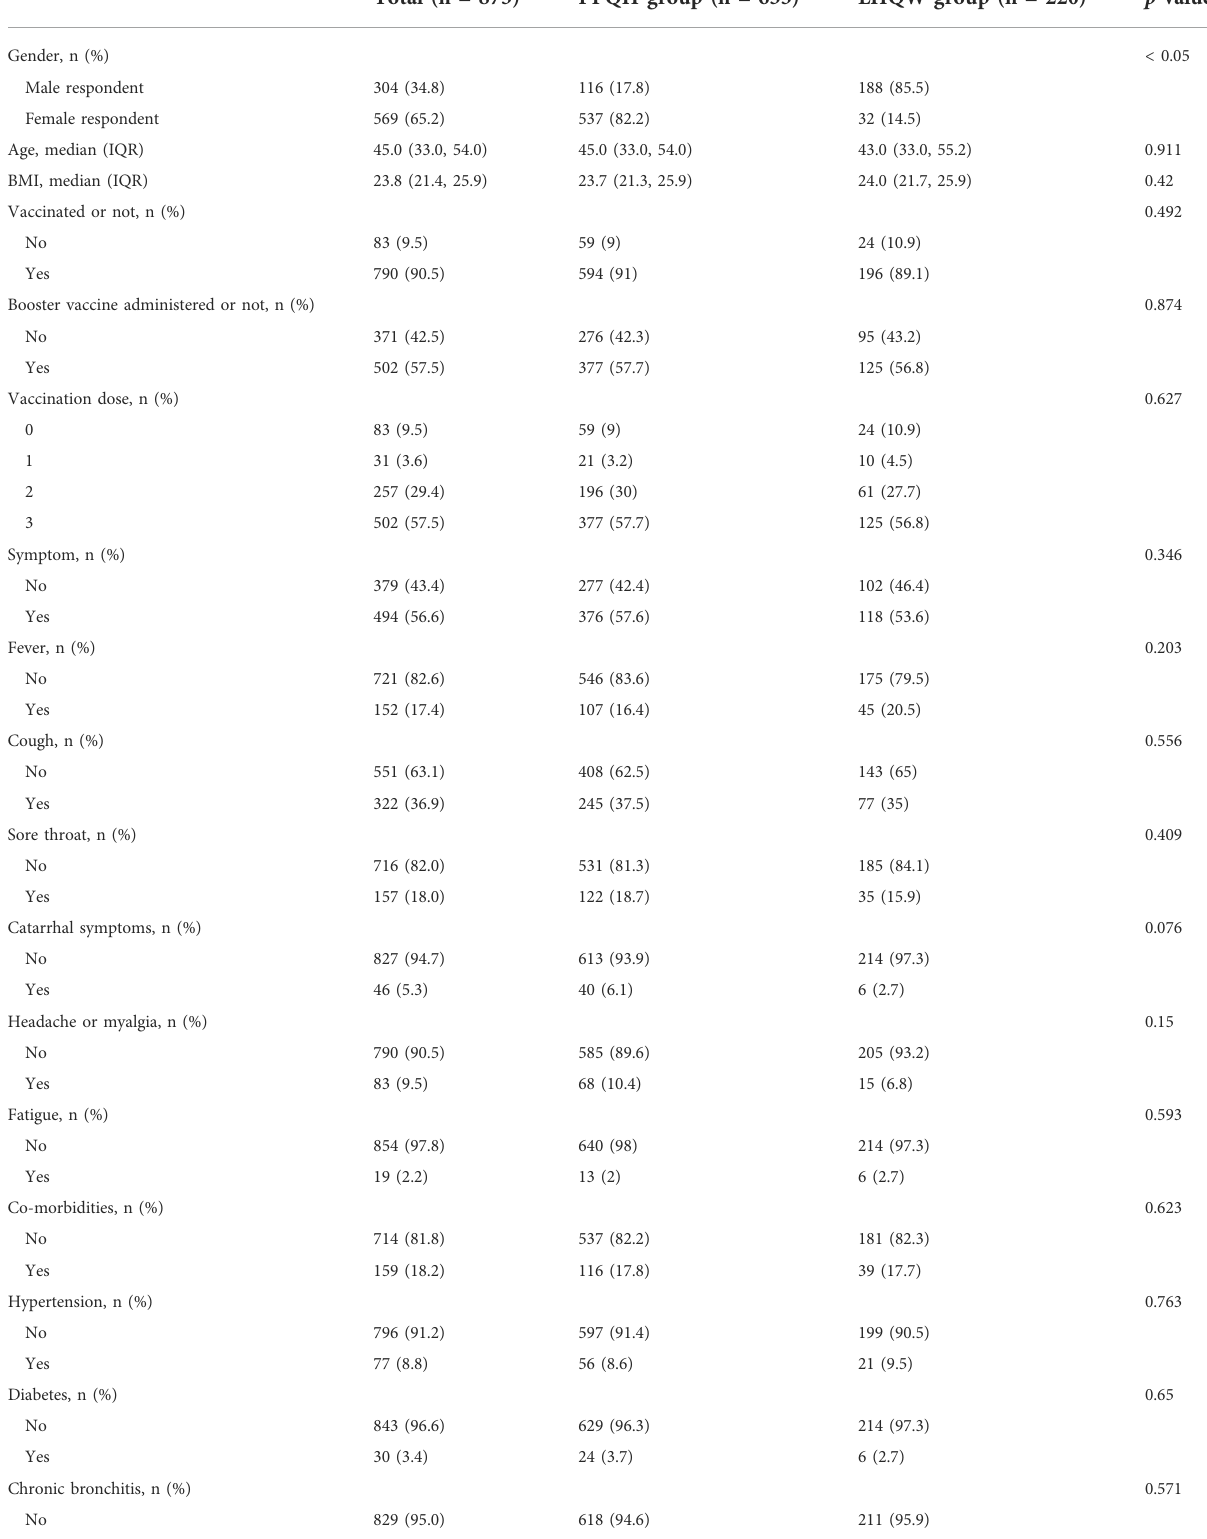
TABLE 1 Comparison of the baseline clinical data between the two groups of SARS-CoV-2-infected patients. Total (n = 873) PPQH group (n = 653) LHQW group (n = 220) p value Gender, n (%) <